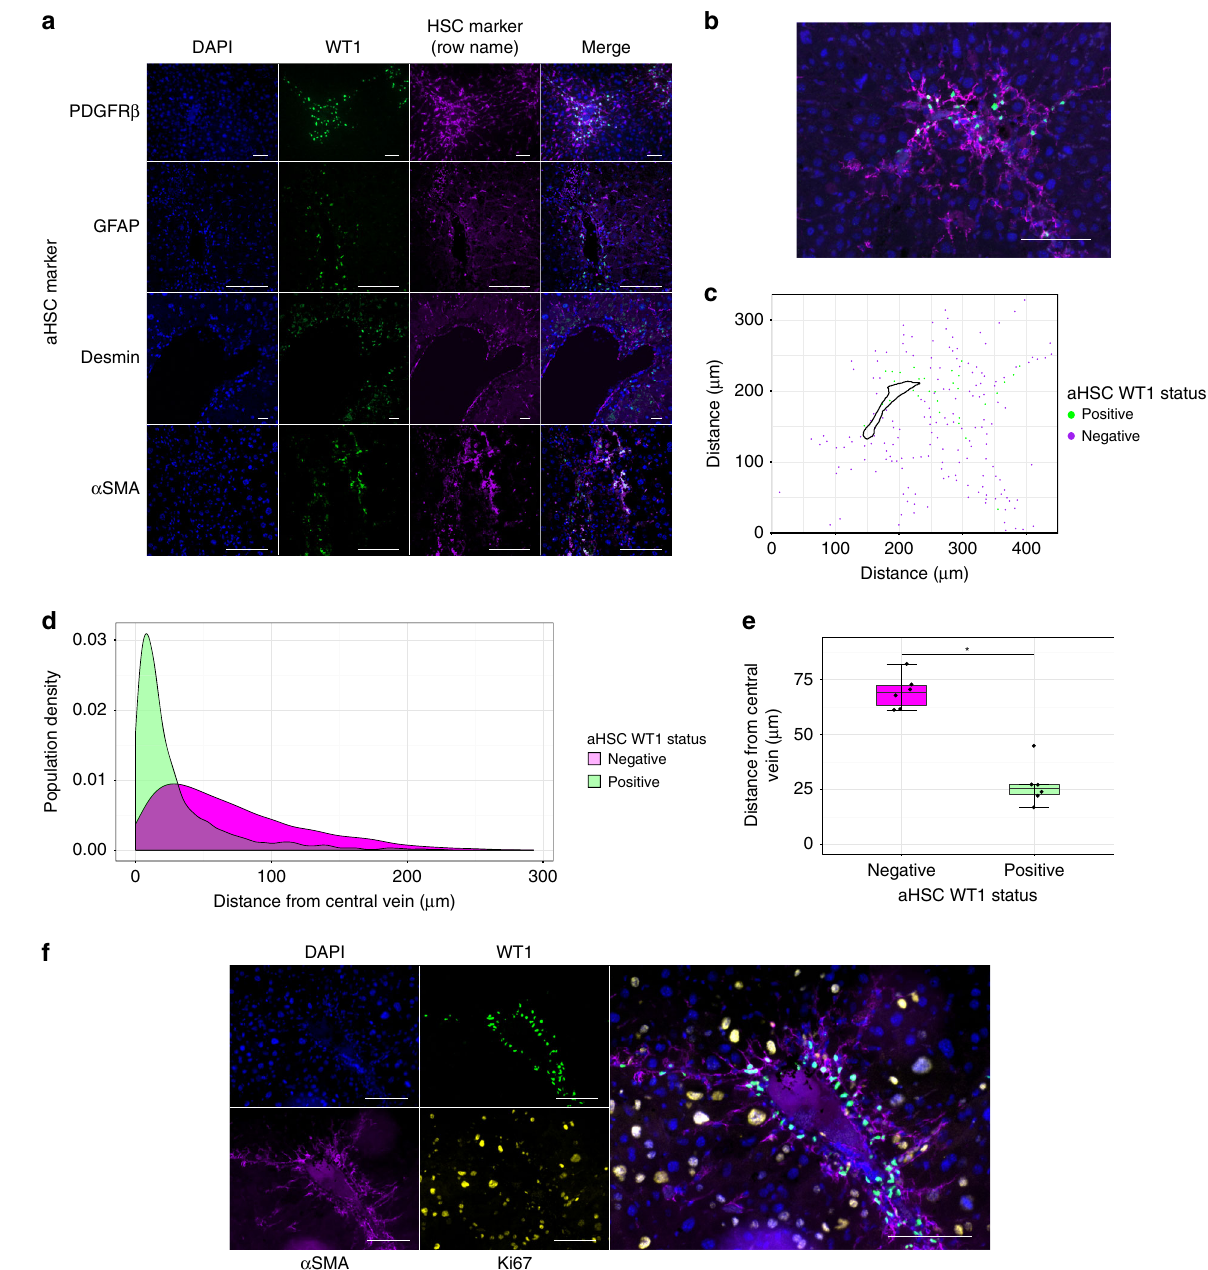
Fig. 3 Subpopulations of aHSCs de fi ned by WT1 expression are distributed differentially within hepatic scars and show differences in cell cycling. a WT1- positive cells are present in murine liver injured by CCl 4 injection, colocalizing with markers of aHSCs (rows show colocalized staining with PDGFR β , GFAP, desmin, and α SMA). Scale bars 100 μ m. b The nuclear position of WT1-positive and WT1-negative aHSCs, and hepatic vein pro fi le were marked in each image of liver from animals chronically injured with CCl 4 to allow quanti fi cation of the fi brospatial distribution of aHSCs ( c ). Scale bars 100 μ m. d The distances from nuclei to central vein were calculated for each biological replicate, demonstrating different distributions within hepatic scars of WT1-positive and WT1-negative aHSCs (representative density distribution plot, bootstrapped Kolmogorov – Smirnov test p < 0.00001). e The mean distances of WT1- positive and WT1-negative aHSCs to the central vein, on a per animal basis, were calculated to show that WT1-positive cells were signi fi cantly closer to central vein pro fi les (*, Welch two-sample t -test, t (9.6195) = 8.4046, p = 0.0000098, n = 6). Data are represented as individual points with median (centre line), fi rst and third quartiles (lower and upper box limits), 1.5× interquartile range (whiskers). f Livers injured with chronic CCl 4 injection were stained for WT1, Ki67, and α SMA. Ki67 immunopositivity was signi fi cantly greater for WT1-negative compared with WT1-positive aHSCs (Welch two- sample t -test, p < 0.001, 20.3 ± 0.9% versus 1.9 ± 0.7%, 10 pericentral fi elds/animal, n = 3). Scale bars 100 μ subpopulations were plated separately back onto plastic and allowed to adhere overnight. WT1-high cells were round, whilst WT1-intermediate and WT1-negative cells were classical MFB-shaped (Fig. 4c).